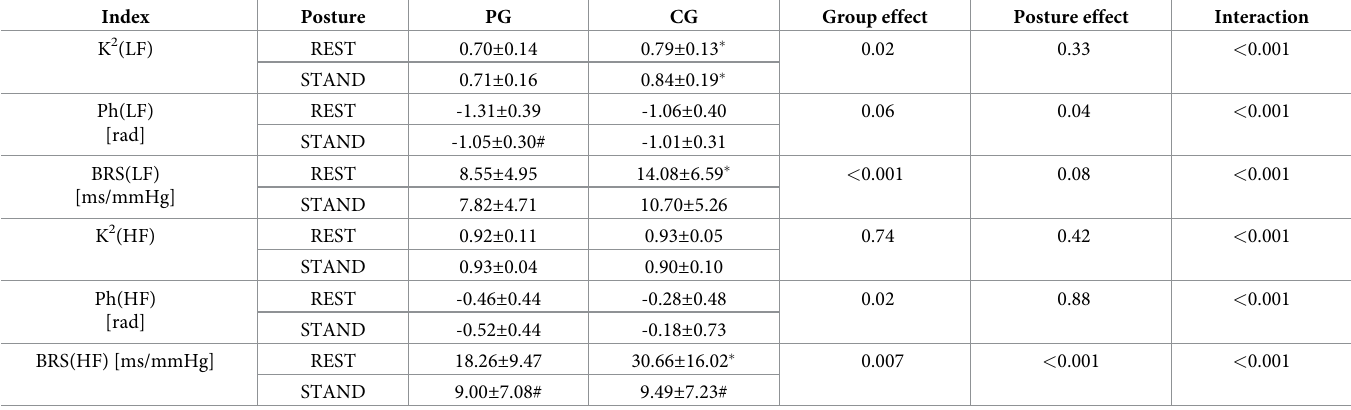
Table 4. HP-SAP cross-spectral indexes in PG and